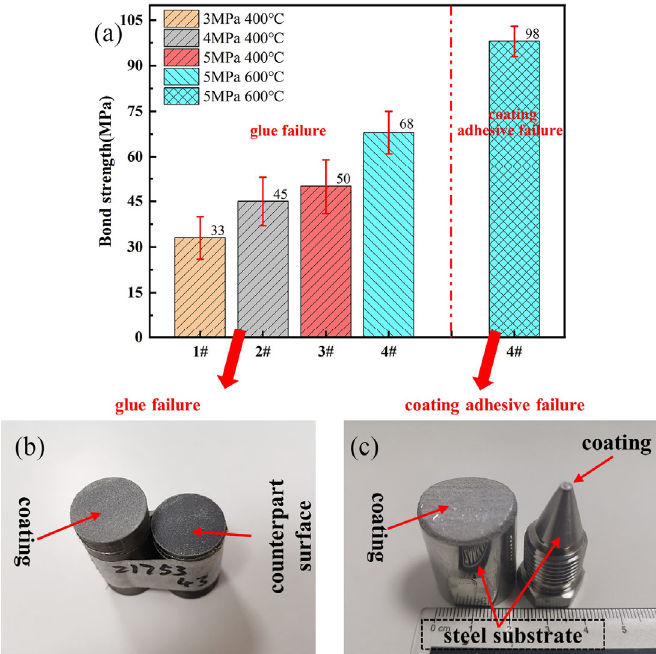
Figure 5. Bond strength results ( a ) and di ff erent testing methods of cold sprayed Al coatings: ( b ) ASTM C633 standard, ( c ) micro-tensile test.